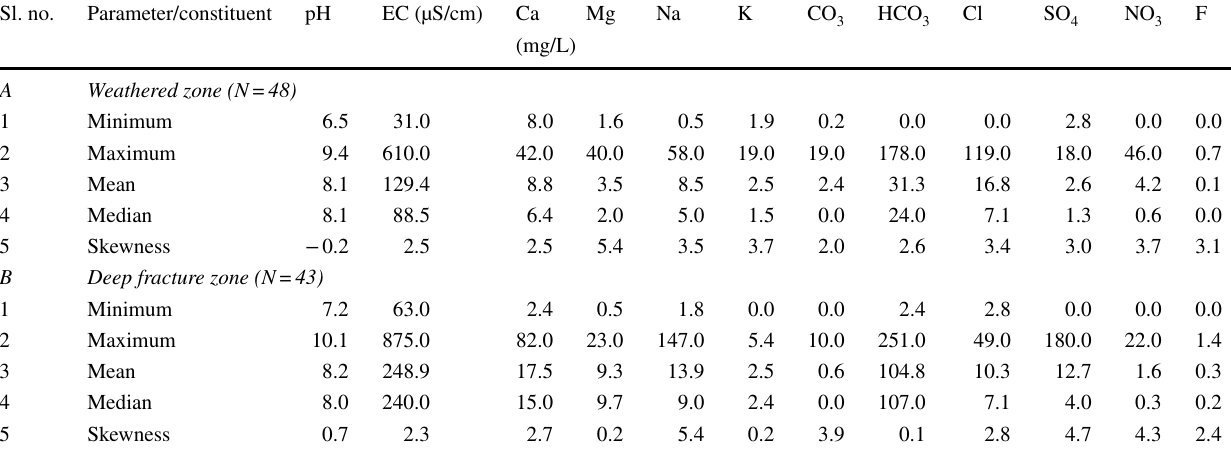
Fig. 2 Box plots of cations and anions in groundwater in charnockites of